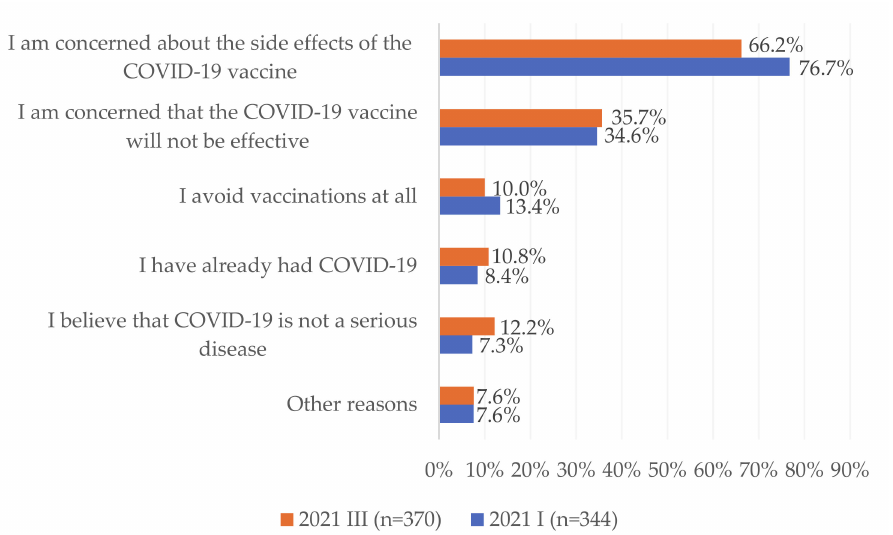
Figure 4. Reasons for negative attitudes towards the COVID-19 vaccine and the lack of willingness to get vaccinated among respondents, who declared that they would not be vaccinated